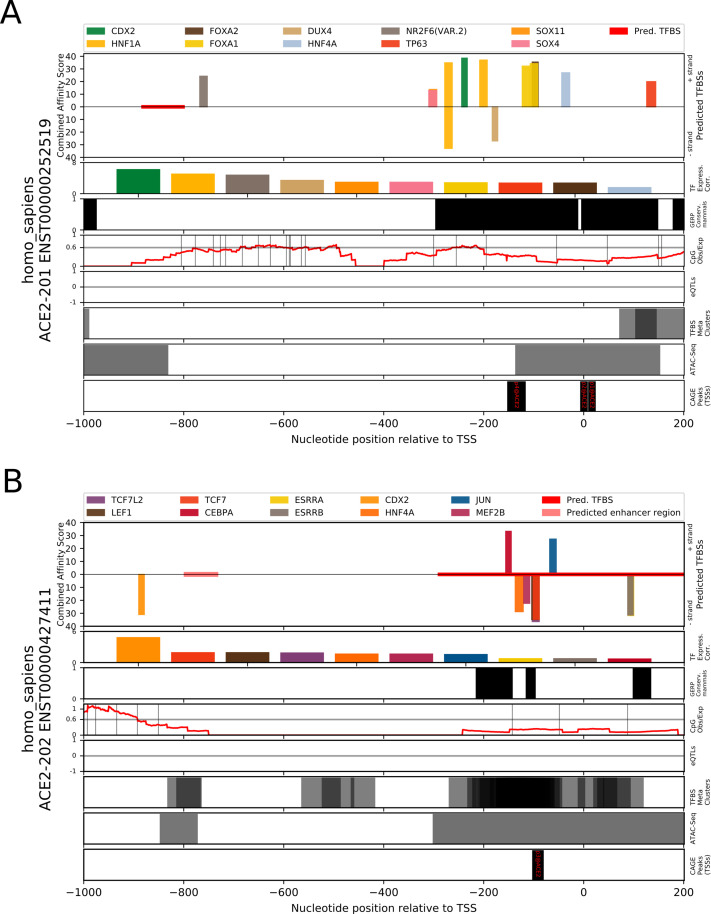
Prediction of transcription factor binding sites in the human ACE2 gene promoter regions of Ensembl transcripts ENST00000252519 and ENST00000427411 using TFBSfootprinter.A) Promoter region of the intestine specific ACE2 transcript. The results show putative binding sites for several transcription factors which have a strong correlation of expression with ACE2 in colon, kidney, and ileum. The predicted binding sites overlap regions of conservation in mammal species (Ensembl GERP), and cluster within 400 base pairs (bp) of the transcription start site. B) Promoter region of the lung specific ACE2 transcript. The predicted binding sites cluster within 200 bp of the TSS and overlap regions of conservation in mammal species, ATAC-Seq peaks (ENCODE), and TFBS metaclusters (GTRD).